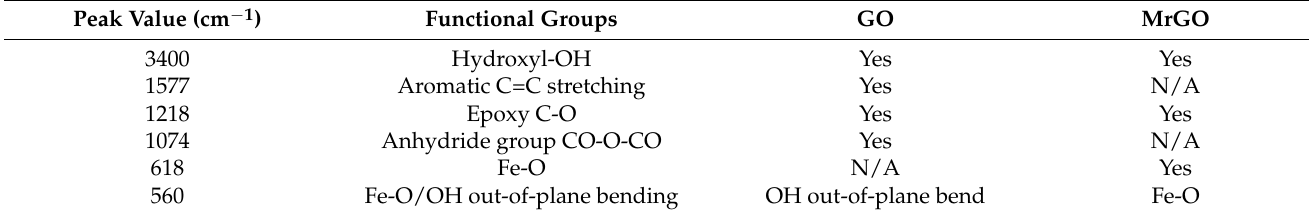
Table 5. FTIR analysis of GO and